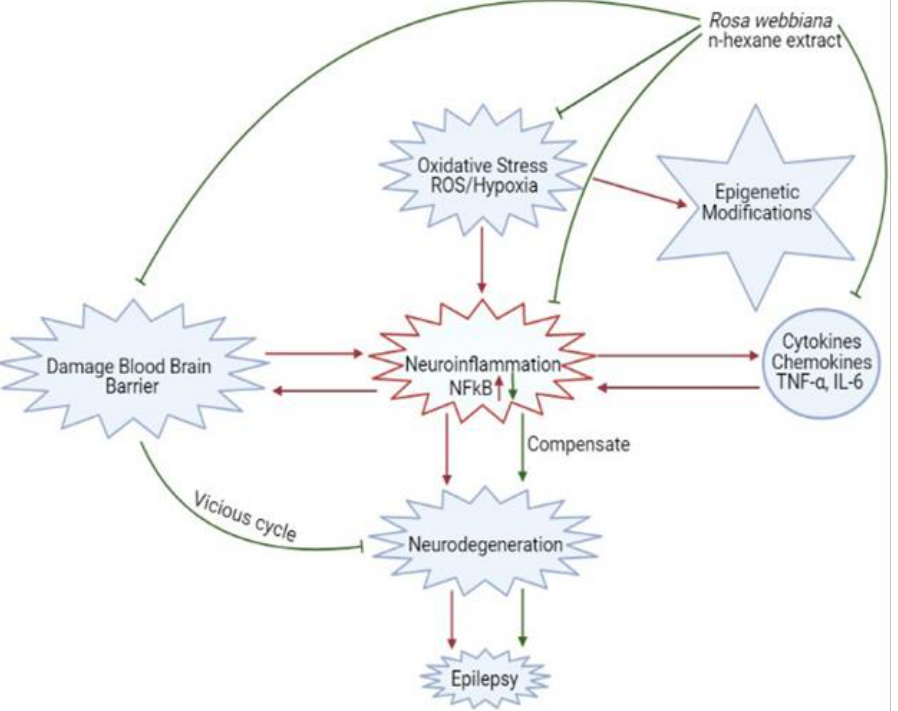
Figure 10. Schematic description of the contribution of oxidative stress, neuro-inflammation and blood–brain barrier destruction in epileptogenesis and the protective mechanisms of Rosa webbiana , including antioxidant mechanisms, neuroprotection through reduced cytokine release (TNF- α ) and downstream NF-kB inhibition and improved drug delivery.